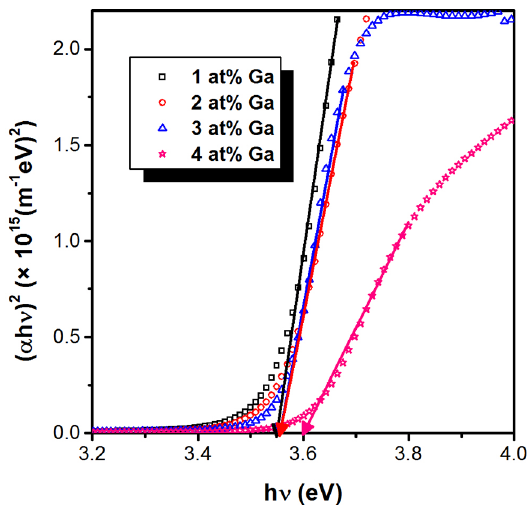
Figure 5. Tauc plot of Ga doped Zn gap energy (E